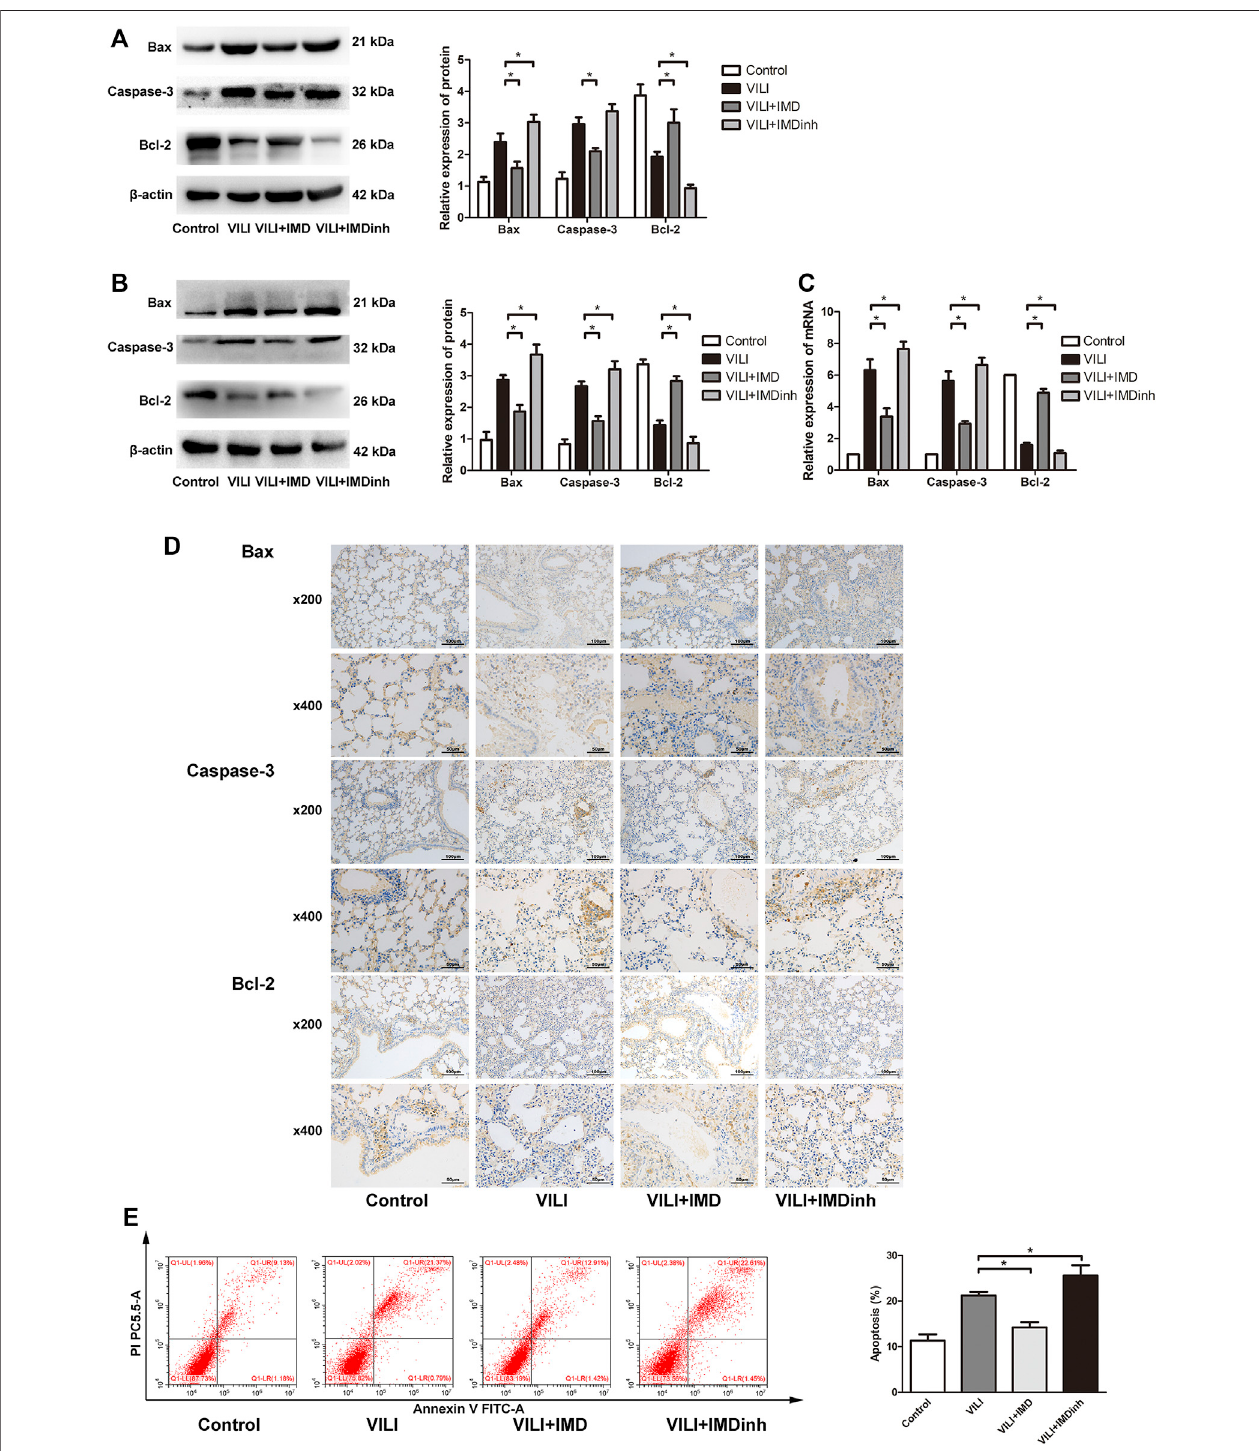
FIGURE 2 | IMD alleviated apoptosis in mice and in ECs. Western blot analysis of Bax, caspase-3, Bcl-2 and β -actin in lung tissues (A) and ECs (B) . (C) Immunohistochemistry of Bax, caspase-3, Bcl-2 and β -actin in lung tissues. (D) Cell apoptosis rate was detected using fl ow cytometry. * p < 0.05.